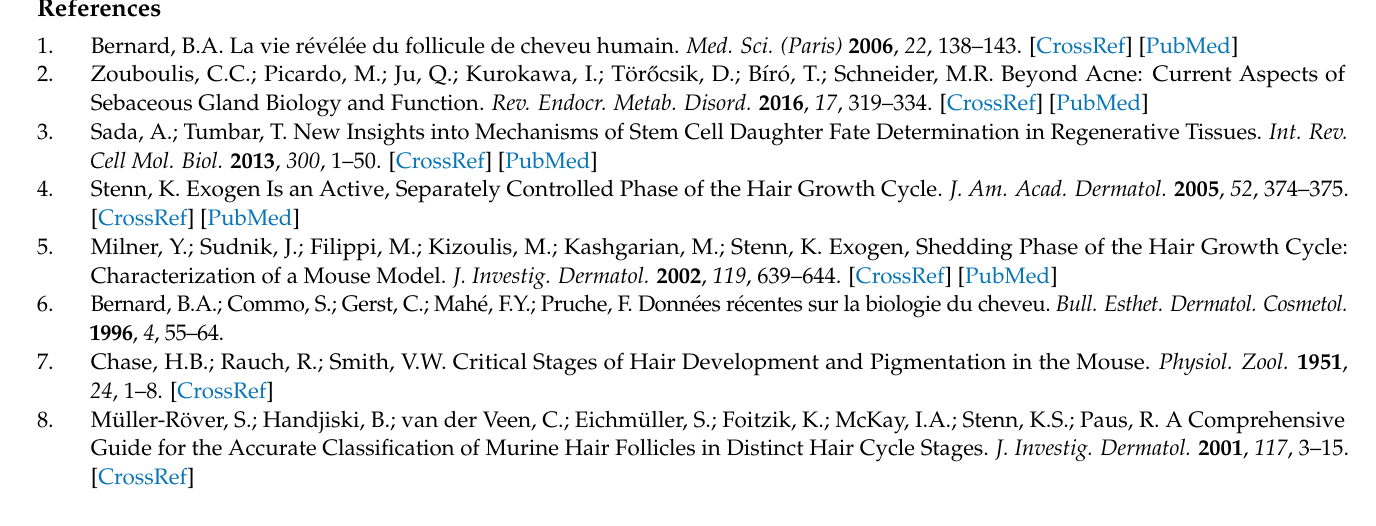
(A–C) Loading vectors 2 and 3 obtained from Figure 6A (A), loading vectors 1 and 2 obtained from Figure 6B (B), and loading vectors 1 and 2 obtained from Figure 7A